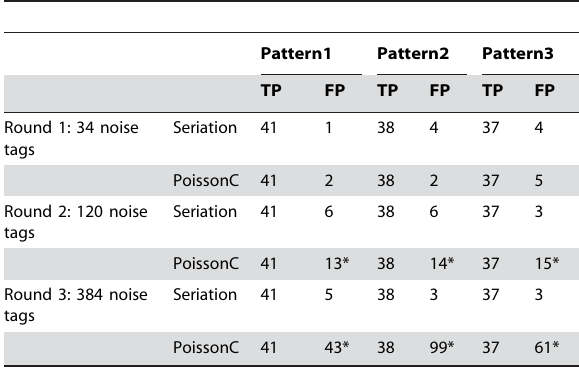
Table 1. Effect of the amount of noise in SAGE data on the performance of seriation and PoissonC.